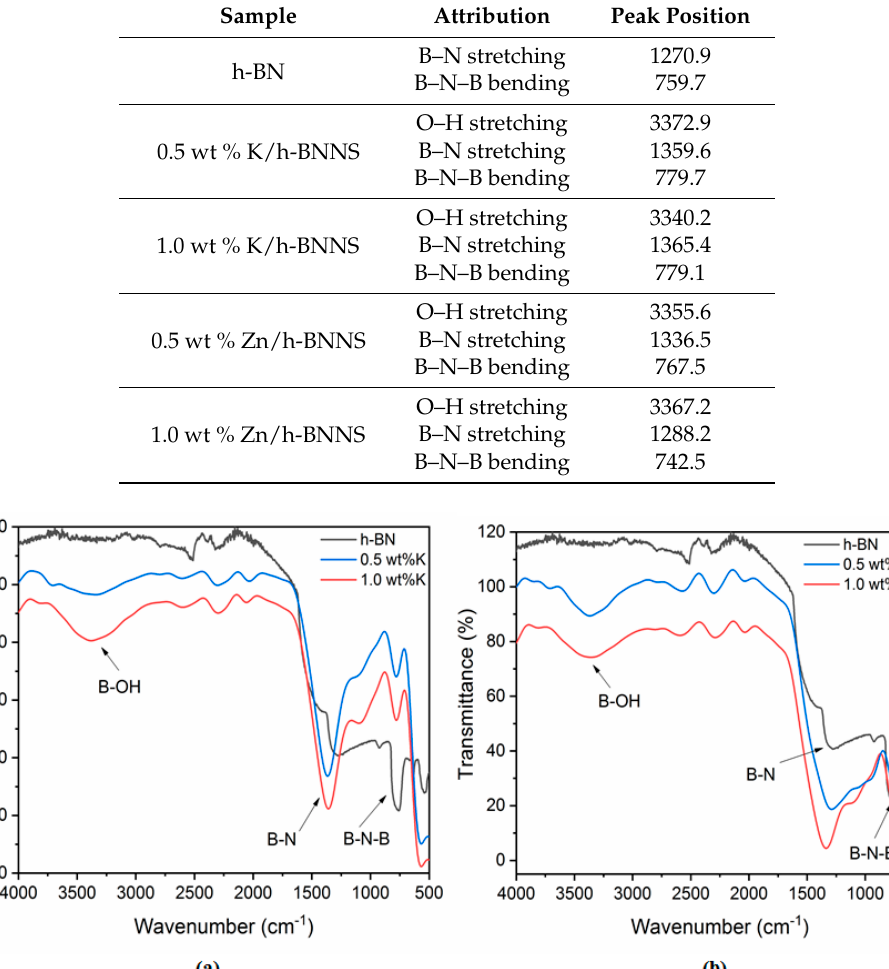
Figure 5. ( a ) FTIR spectra of pristine h-BN of and h-BNNS intercalated with Zn 2+ at different concentrations (0.5 wt % and 1.0 wt % KCl); and ( b ) FTIR spectra of pristine h-BN of and h-BNNS intercalated with Zn 2+ at different concentrations (0.5 wt % and 1.0 wt %).